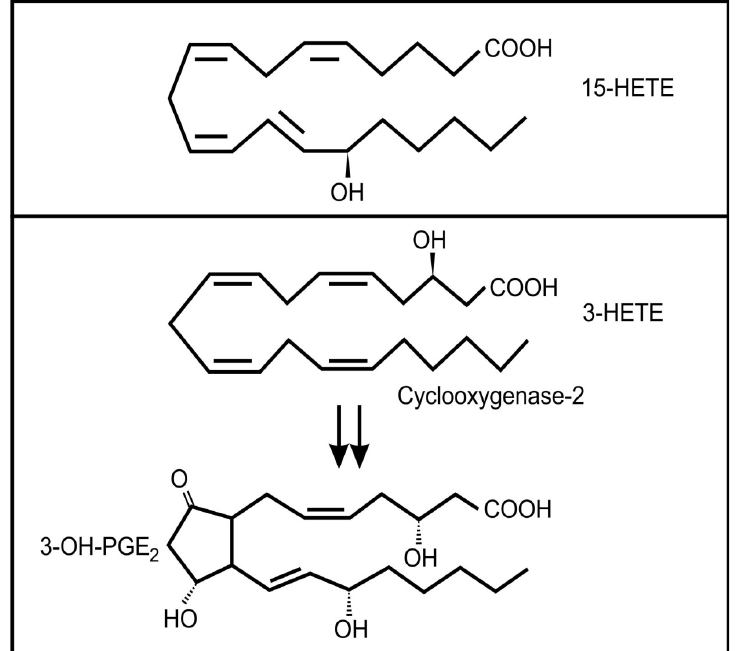
Figure 4. Oxidized fatty acids involved in cross-kingdom signaling between bacteria and animals ( a ) 15-hydroxyeicosatetraenoic acid (13-HETE); ( b ) The conversion of 3-HETE to 3-OH-prostaglandin E 2